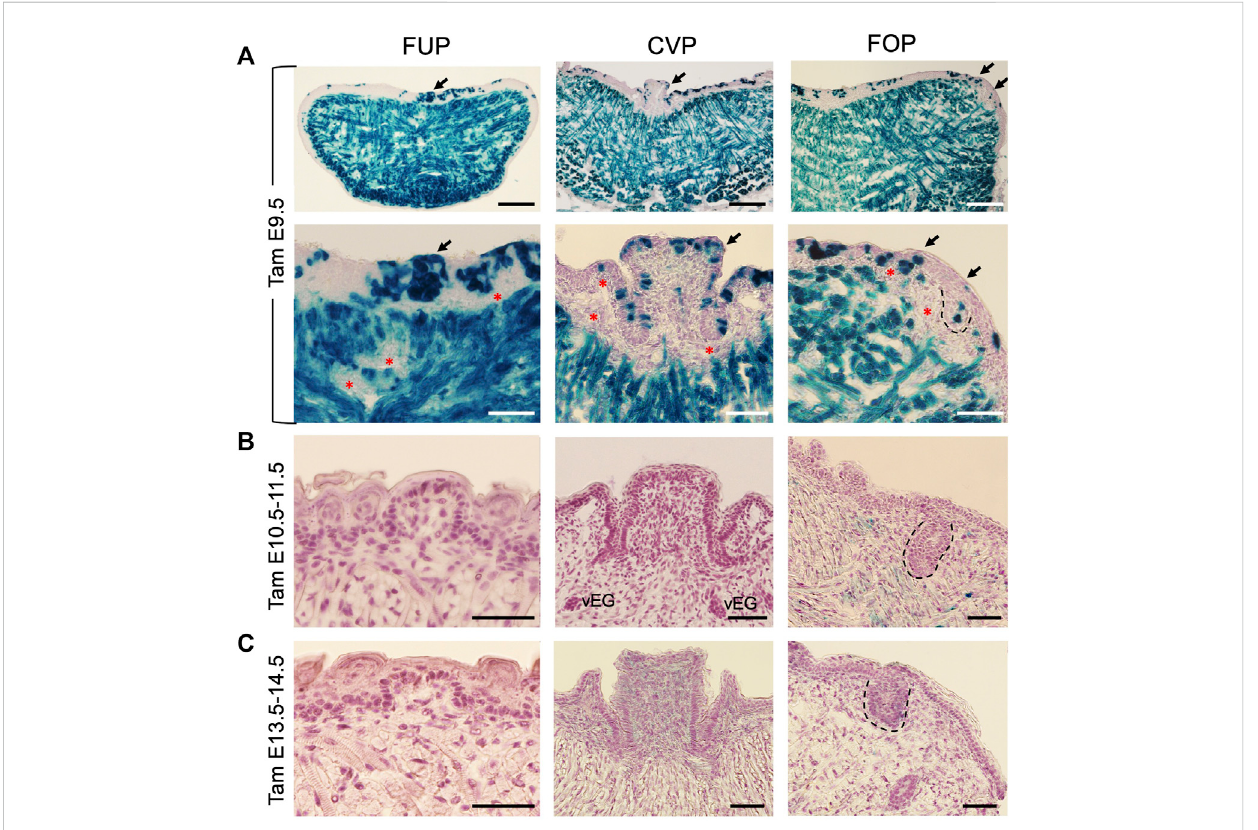
FIGURE 3 Lineage tracing reveals the contribution of Eya1- expressing progenitors before E10.5 to tongue epithelium, taste papillae, and tongue musculature. (A – C) X-Gal stained frontal sections of Eya1 CreER ;R26R LacZ at E17.5 – 18.5 showing labeled cells in the tongue muscles, lingual epithelium, and taste papilla regions when tamoxifen (tam) was administered at E9.5 (A) , but not at E10.5 and 11.5 (B) or E13.5 and 14.5 (C) . Bottom panels in A show a higher magni fi cation of areas indicated by arrows. The FOP was outlined by dashed lines. Red asterisks indicate unmarked mesenchymal cells. Abb.: vEG, von Ebner ’ s gland. Scale bars: 200 μ m for the top panels in A and 50 μ m for all other